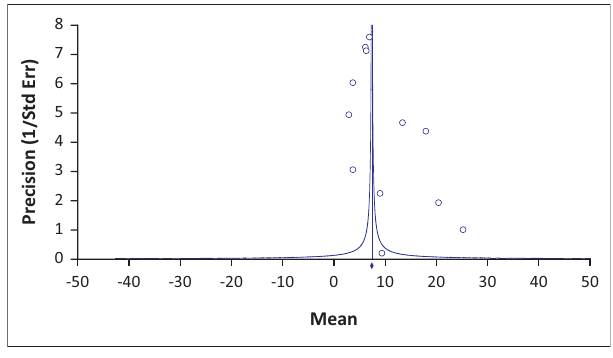
FIGURE 4: Plots of precision (1/standard error) by estimation of